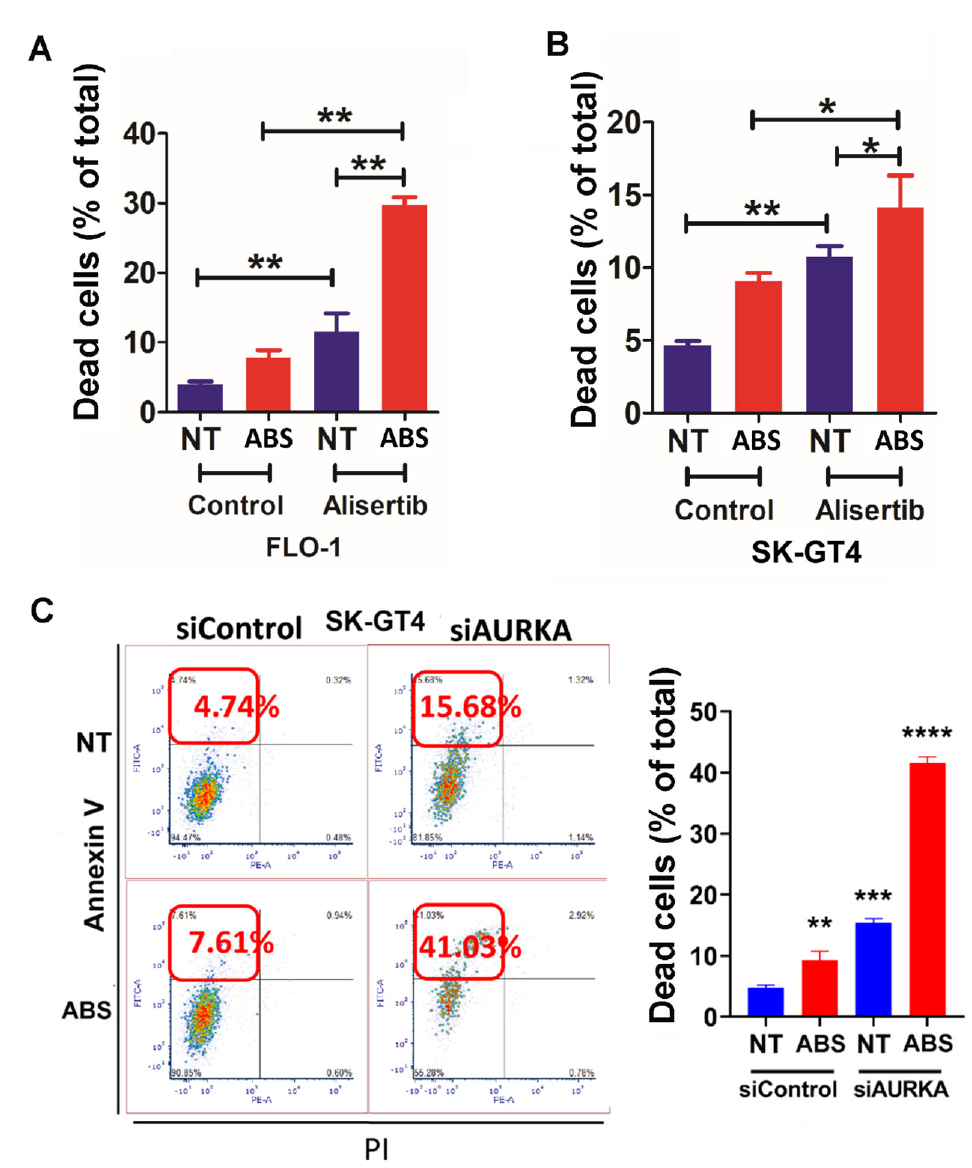
Figure 4. AURKA protects EAC cells from ABS-induced cell death. ( A ) Apoptotic cell quantification based on flow cytometry analysis of Annexin V and PI staining in FLO-1 cells with alisertib (200 nM, 24 h), ABS (pH 4.0, 200 μM, 20′ + 3 h recovery), or a combination. ( B ) Similar results in SK-GT4 cells as in ( A ). ( C ) Left panel: flow cytometry analysis of Annexin V and PI staining in SK-GT4 cells treated with ABS (pH 4.0, 200 μM, 20′ + 3 h recovery) at 72 h after the transfection of control siRNA or AURKA siRNA. Right panel: quantification of Annexin V-positive and PI-negative staining cells from the left panel. * p < 0.05, ** p < 0.01, *** p < 0.001, **** p < 0.0001.